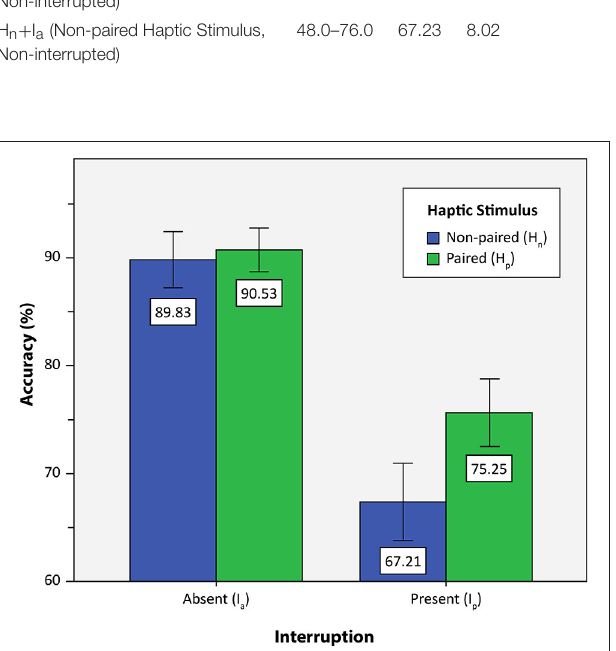
FIGURE 6 | Measured accuracy under the four conditions. Error bars represent the double standard error of the mean.